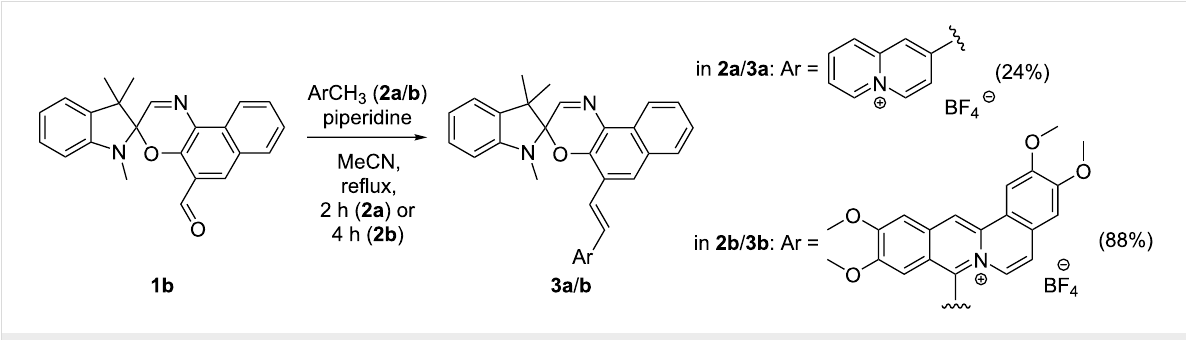
and Scheme S1, Supporting Information File 1). The structures of the new compounds 3a and 3b were confirmed by NMR spectroscopy ( 1 H, 13 C, COSY, HSQC, HMBC), mass spectrom- etry (ESIMS), and elemental